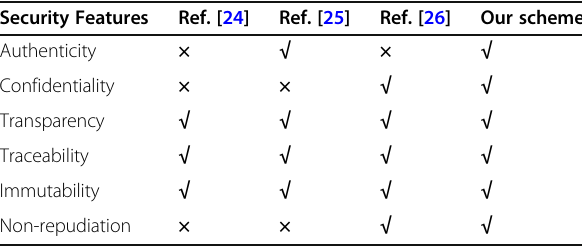
Table 3 Security comparison between our scheme and